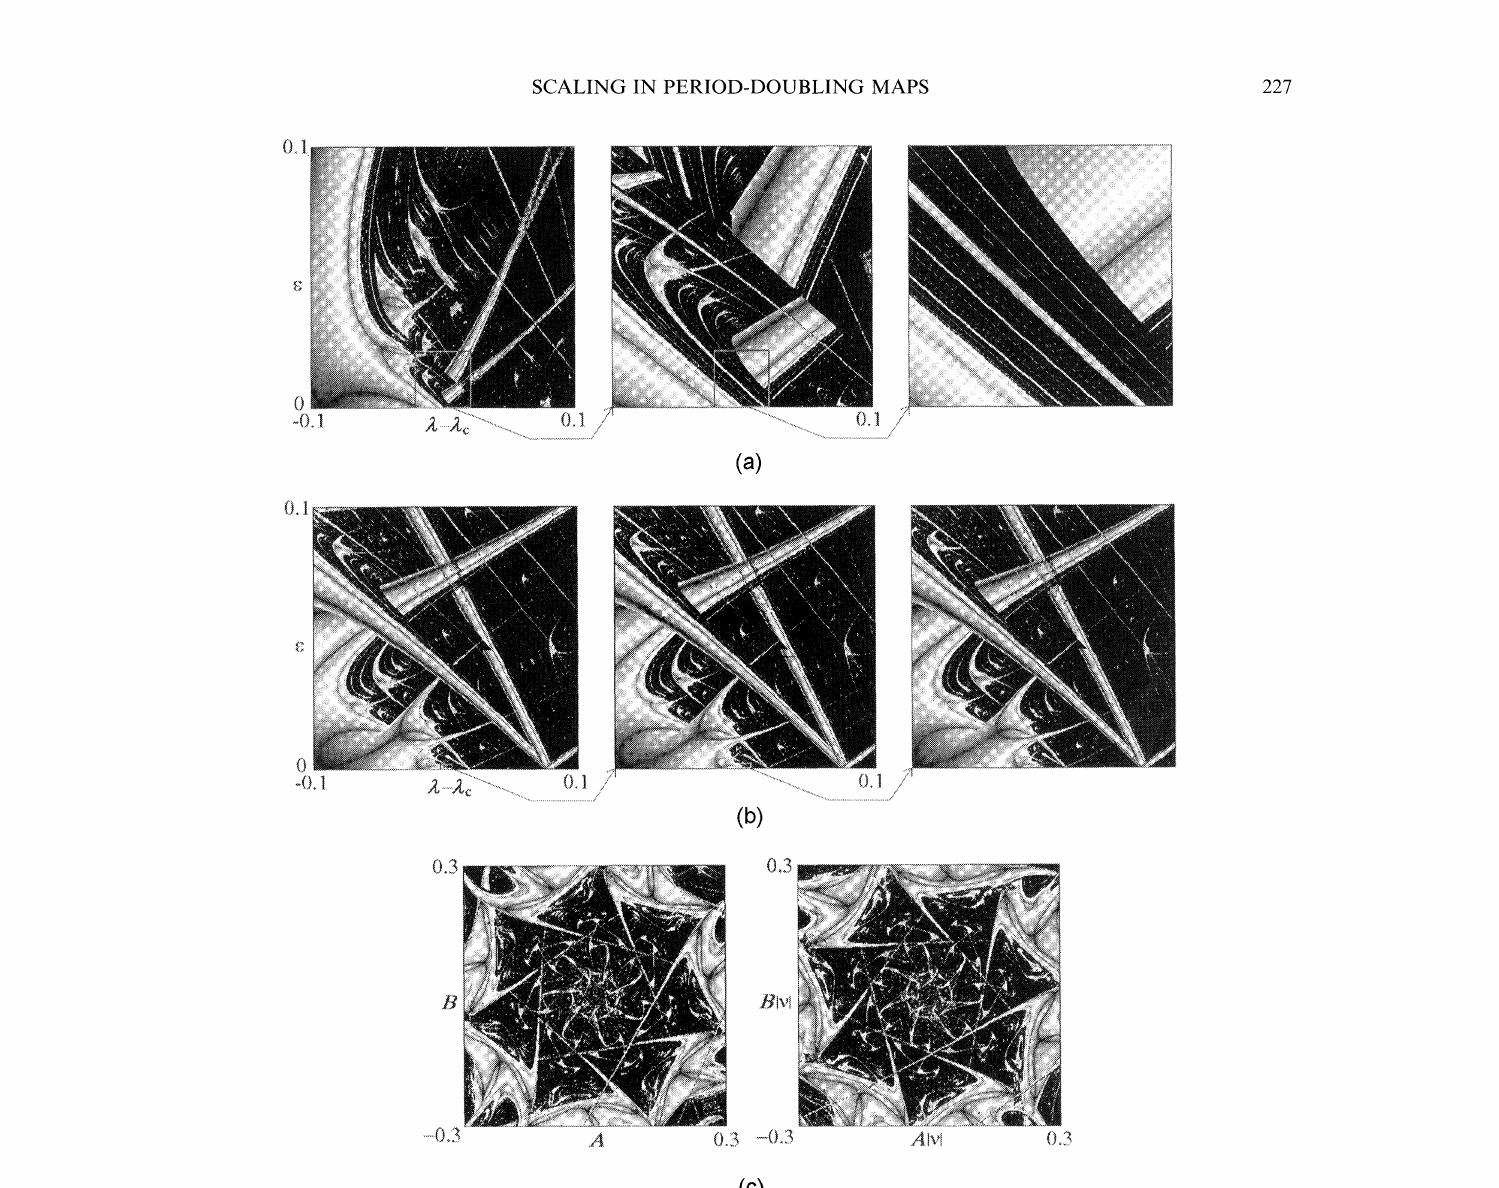
FIGURE Charts of the Lyapunov exponent distributions on the parameter plane (c, ) of the periodically driven logistic map (1) for w=1/8 (a), w= 1/3 (b), and on the plane (A=ecosqS, B=esinqS) at /=,. for w= 1/7 (c). Gray tones from dark to white correspond to Lyapunov exponent values A from minus infinity to zero, and black designates positive A (chaos). Enlargement of small fragments of the pictures illustrates scaling of F-type (a), P-type (b) and Q-type (c). For diagram (a) factors of the enlargement along both coordinate axes are equal to the Feigenbaum constant (5---4.6692; for diagram (b) they are 52 and v(1/3)=58.96, respectively, along the horizontal and vertical axes; for diagram (c) the factors are Iv(1/7)1-296.27. The magnification is accompanied by a redefinition of the gray-scale coding rule to outline self-similarity of the Lyapunov exponent